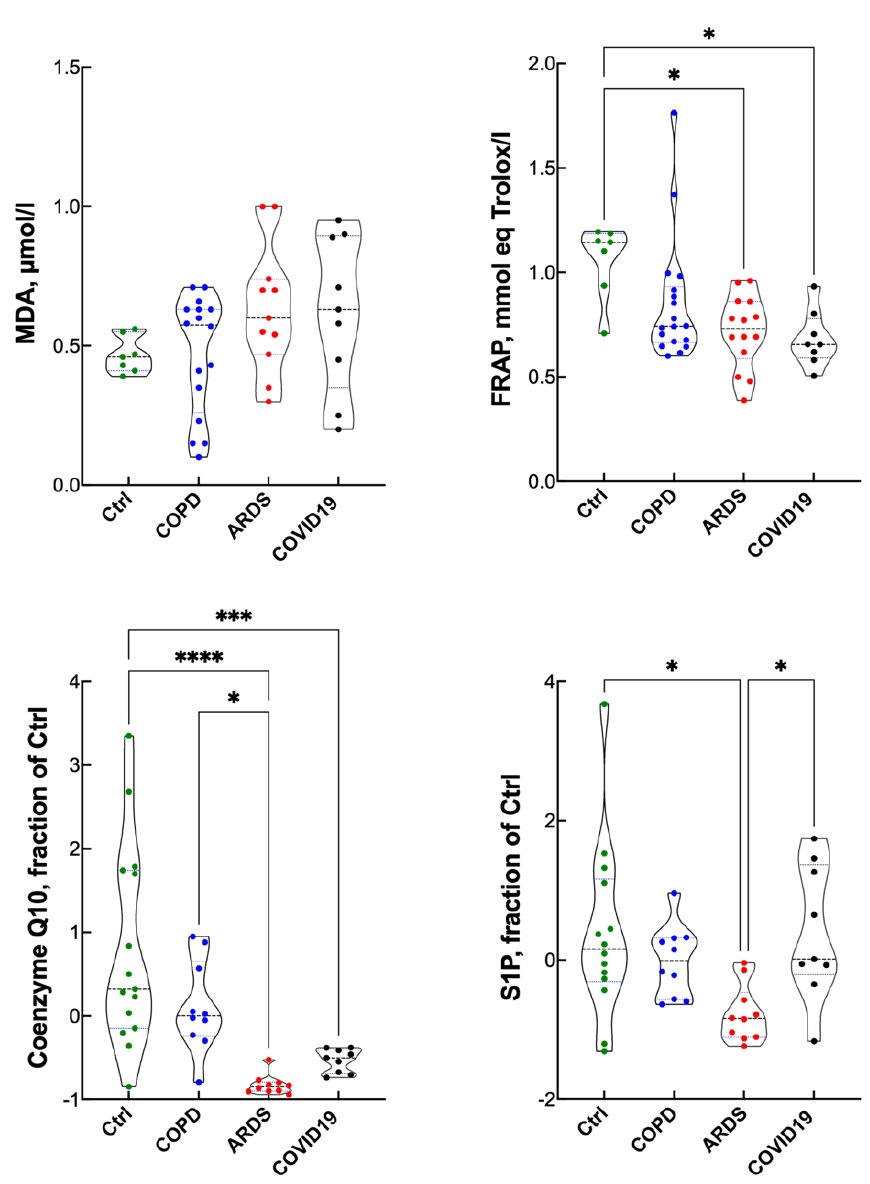
Figure 3. Redox imbalance parameters in controls, COPD, ARDS and COVID-19 (violin plots). ANOVA for MDA was not significant. * p < 0.05; *** p < 0.005; **** p < 0.0001 at the Tukey’s post-